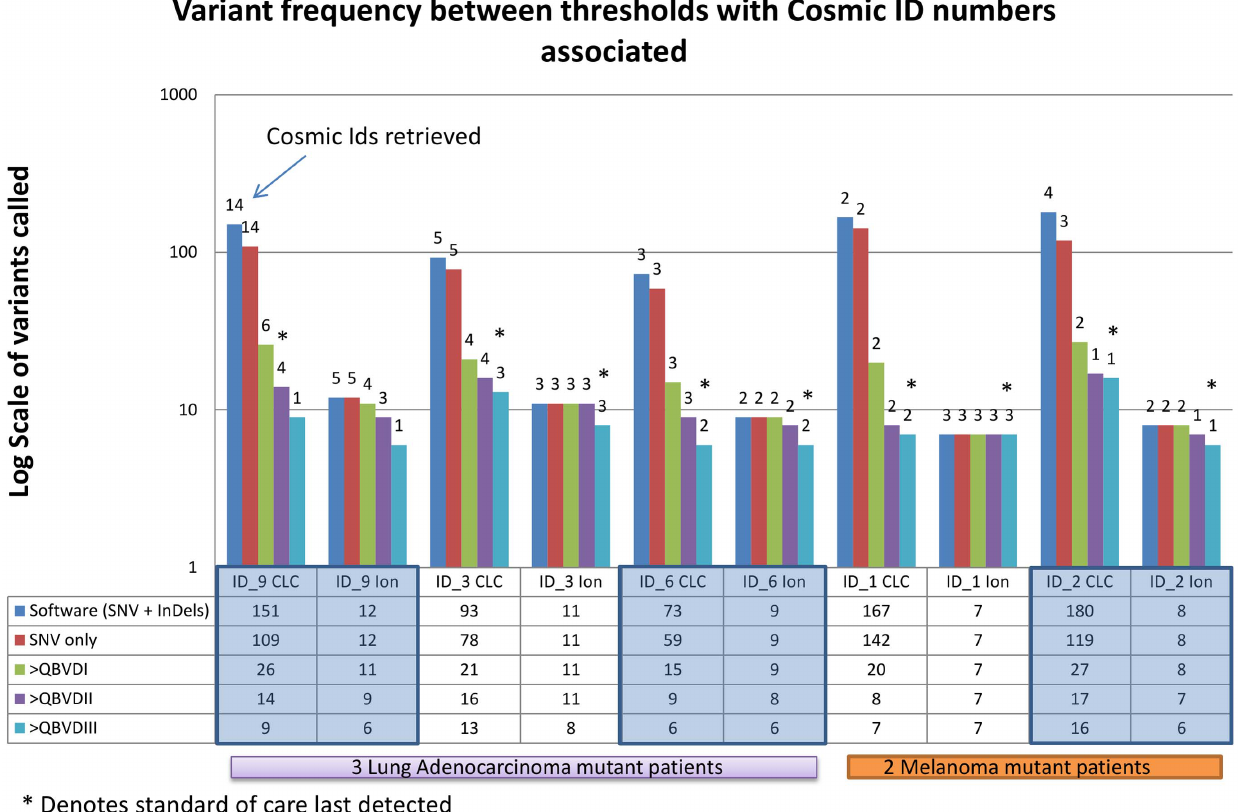
Figure 2. Variant frequency between thresholds with Cosmic IDs associated. The graph illustrates the importance of filtering mutations by applying different detection thresholds in the bioinformatics analysis. ID.1, 2, 3, 6 and 9 were selected as they contained important standard-of-care SNVs.